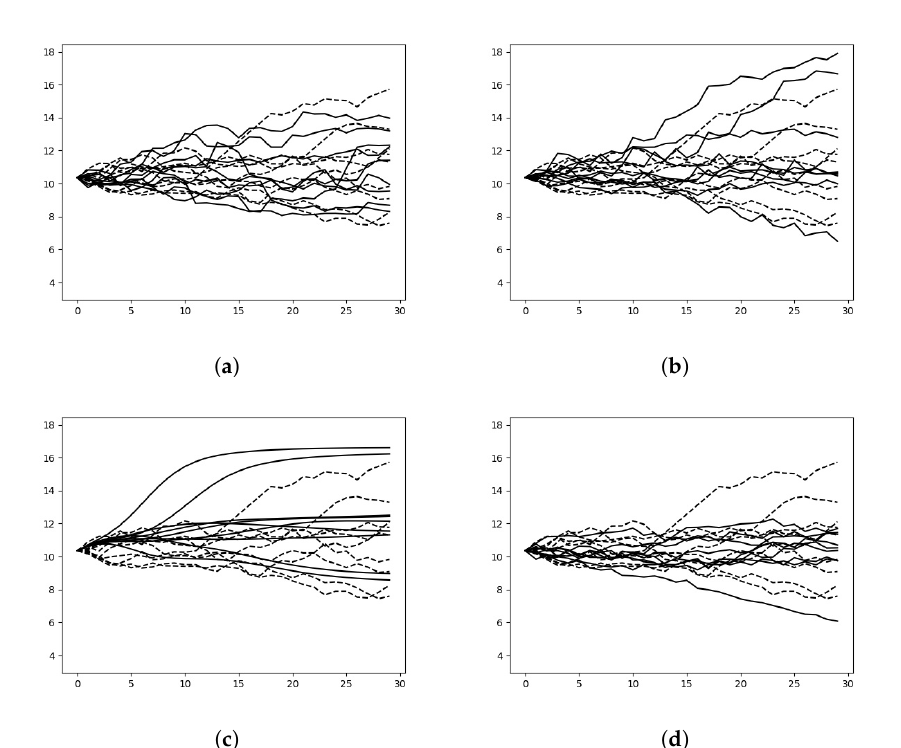
Figure 2. Generation of the 3MAH Gas. Dashed lines represent trajectories of the historical time series, full lines represent samples produced by the generators. ( a ) CEGEN. ( b ) TSGAN. ( c ) COTGAN. ( d )